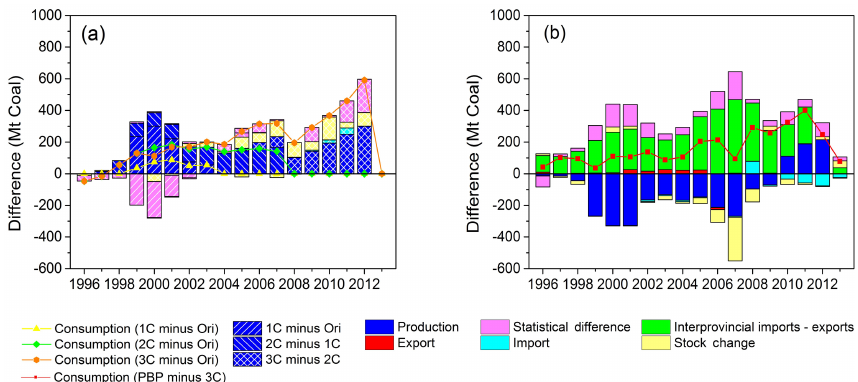
Figure 5. Differences in coal consumption between different energy statistics, from the supply perspective: (a) CT-CESY-1C (1C) / CT- CESY-2C (2C) / CT-CESY-3C (3C) − CT-CESY-Ori (Ori); (b) PBP-CESY (PBP) − CT-CESY-3C (3C). From the supply perspective, con- sumption = production − exports + imports + change in stock + statistical